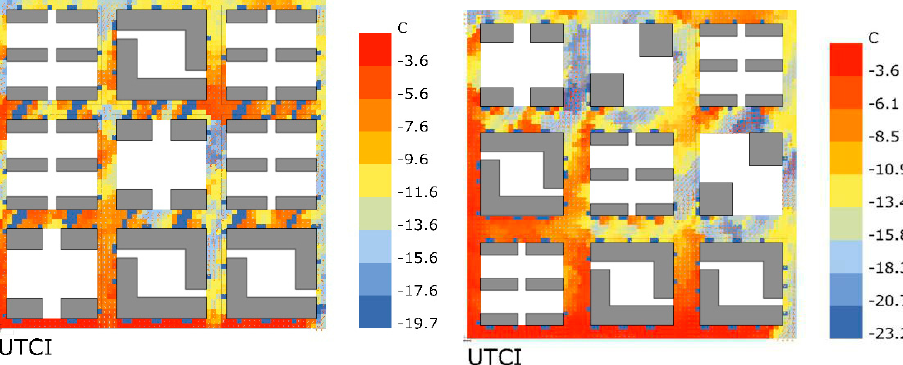
Figure 14. Example optimization results at street level: the best optimization (left, street width: 20 m, acceptable UTCI percentage: 90.6%) and the worst optimization (right, street width: 30 m, acceptable UTCI percentage: 73.7%).